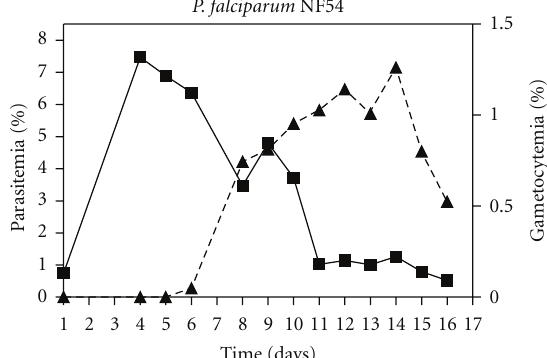
Figure 1: Time course of in vitro production of P. falciparum NF54 gametocytes. Percentage of total parasitemia ( (cid:2) ) and percentage of gametocytes ( (cid:3) ) are